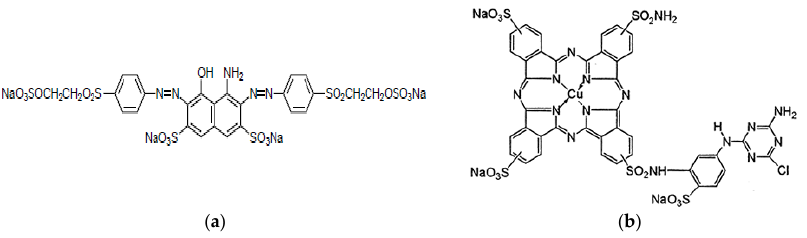
Figure 1. Chemical structure of ( a ) RB5 (C.I. Reactive Black 5); and ( b ) Rb7 (C.I. Reactive Blue 7).